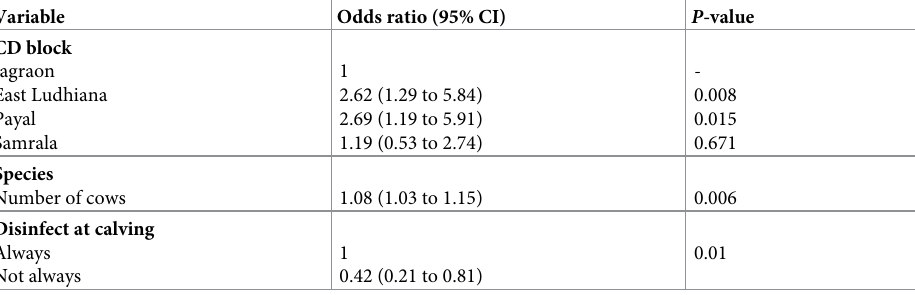
Table 4. Herd-level multivariate GLMM for associations between farm-level risk factors farms testing seropositive for Brucella spp. using logistic regression with village included as a random effect.